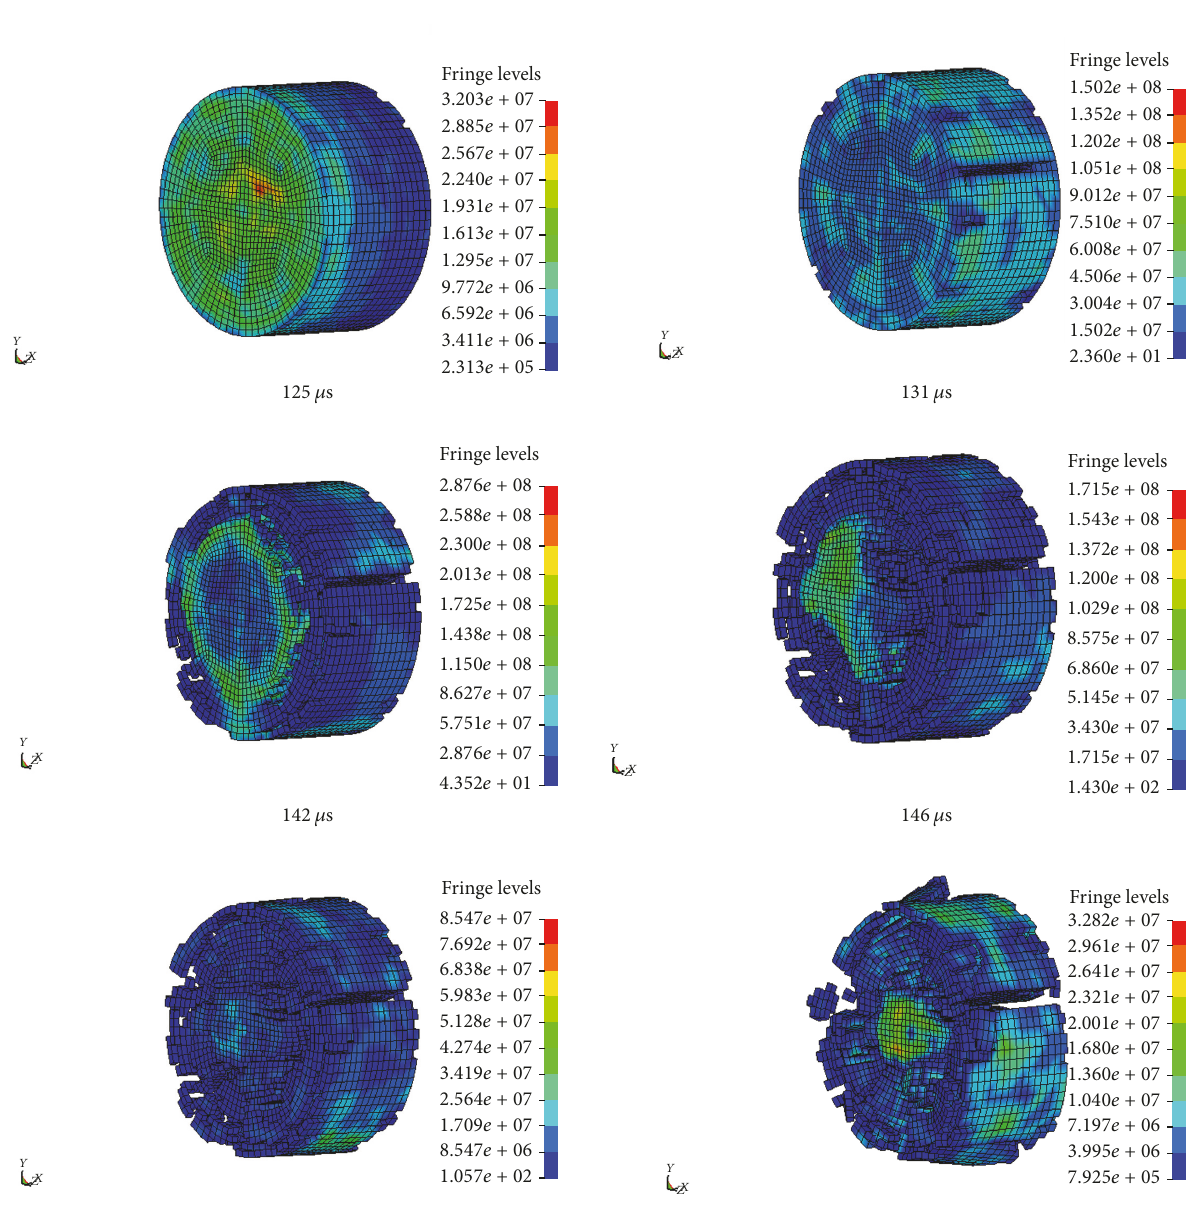
Figure 11: Numerical fracture process (the average strain rate is 52 s −1